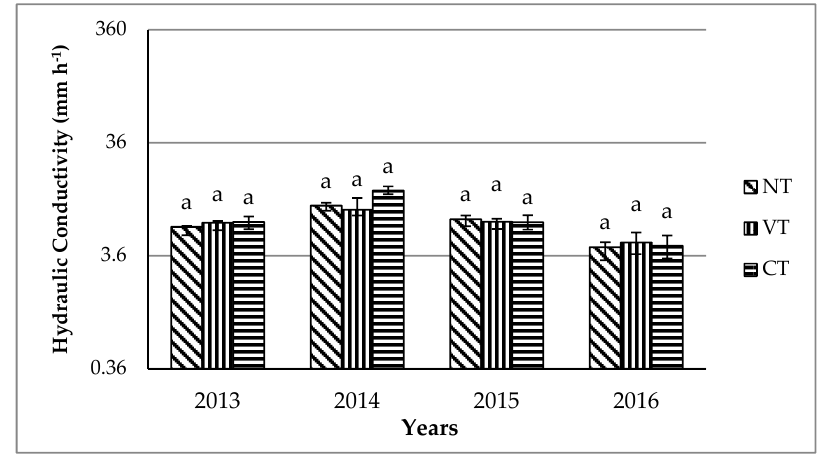
Figure 7. Changes in hydraulic conductivity (Logarithmic scale) over the four-year period, for different tillage systems. Mean values with the same letter in the same year are not significantly different (Tukey α ≤ 0.05). Bars on top of treatment are the standard error.